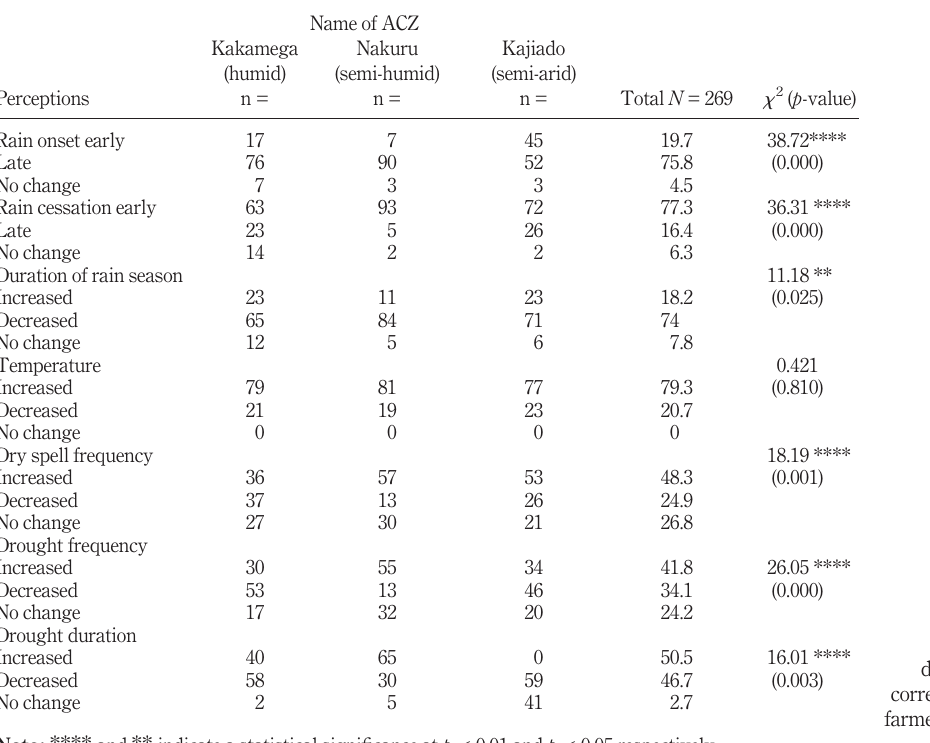
distribution and correlation